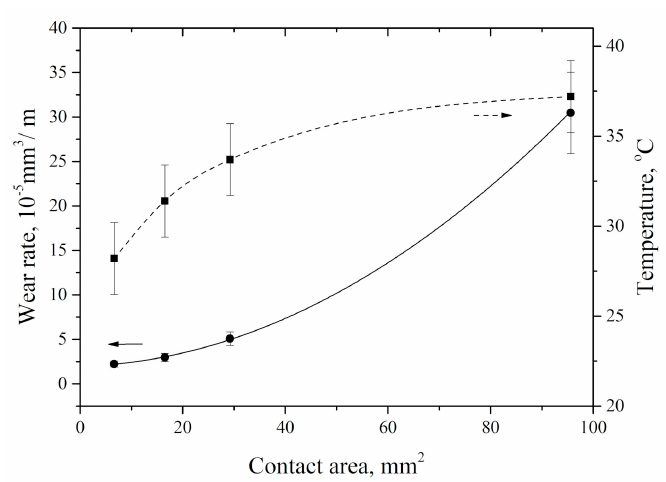
Figure 8. Counterpart temperature and wear rate vs. nominal sample–counterpart contact area.